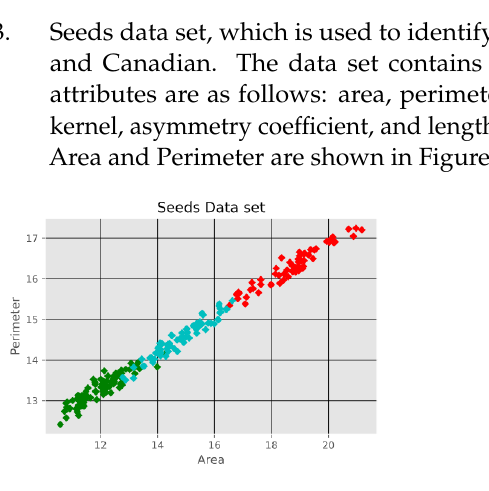
Figure 5. Illustration of the first two attributes of the Seeds data set.